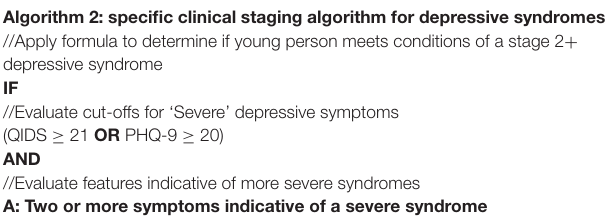
TABLE 3 | Detailed example for the translation of self-report data into clinical staging decisions.